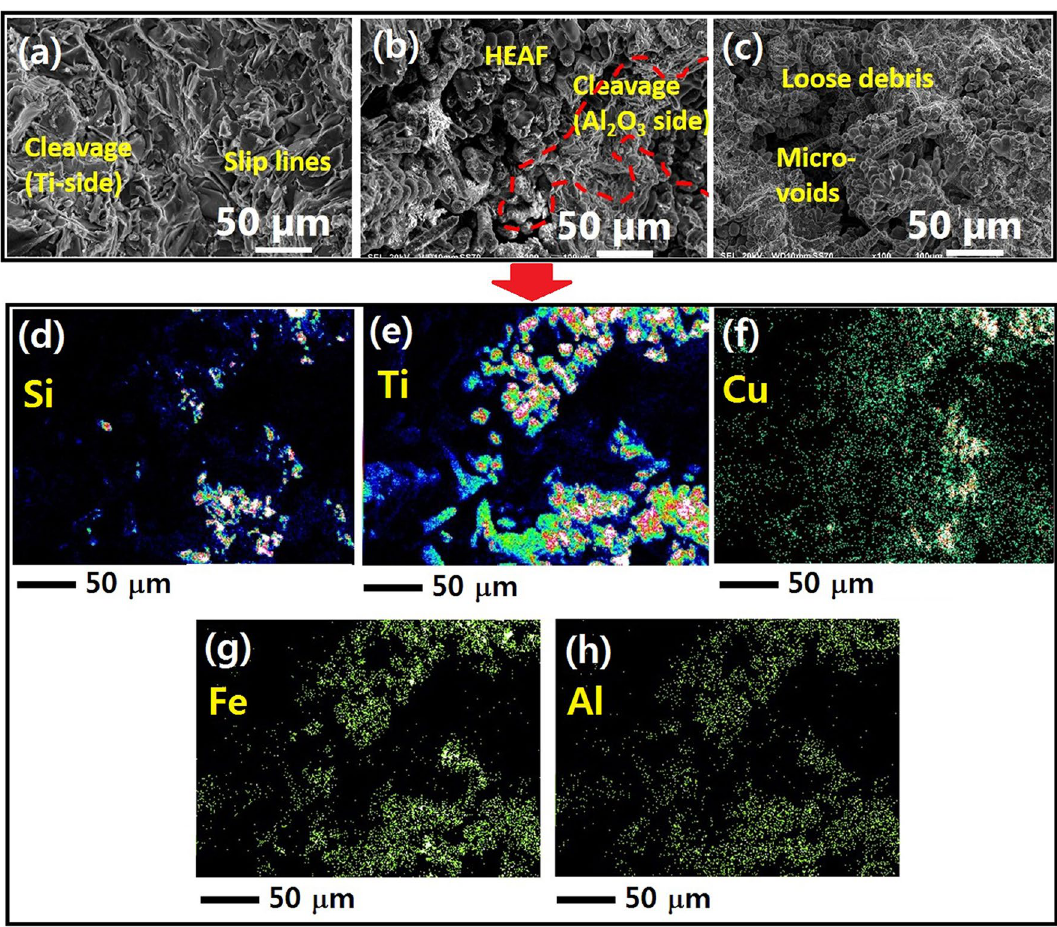
Figure 10. Shear fractured images of the Al 2 O 3 /Ti–6Al–4V joints at ( a ) 1010 °C for 60 s, ( b ) 1050 °C for 60 s, ( c ) 1070 °C for 60 s, and ( d – h ) EDS mapping of joint at 1050 °C for 60